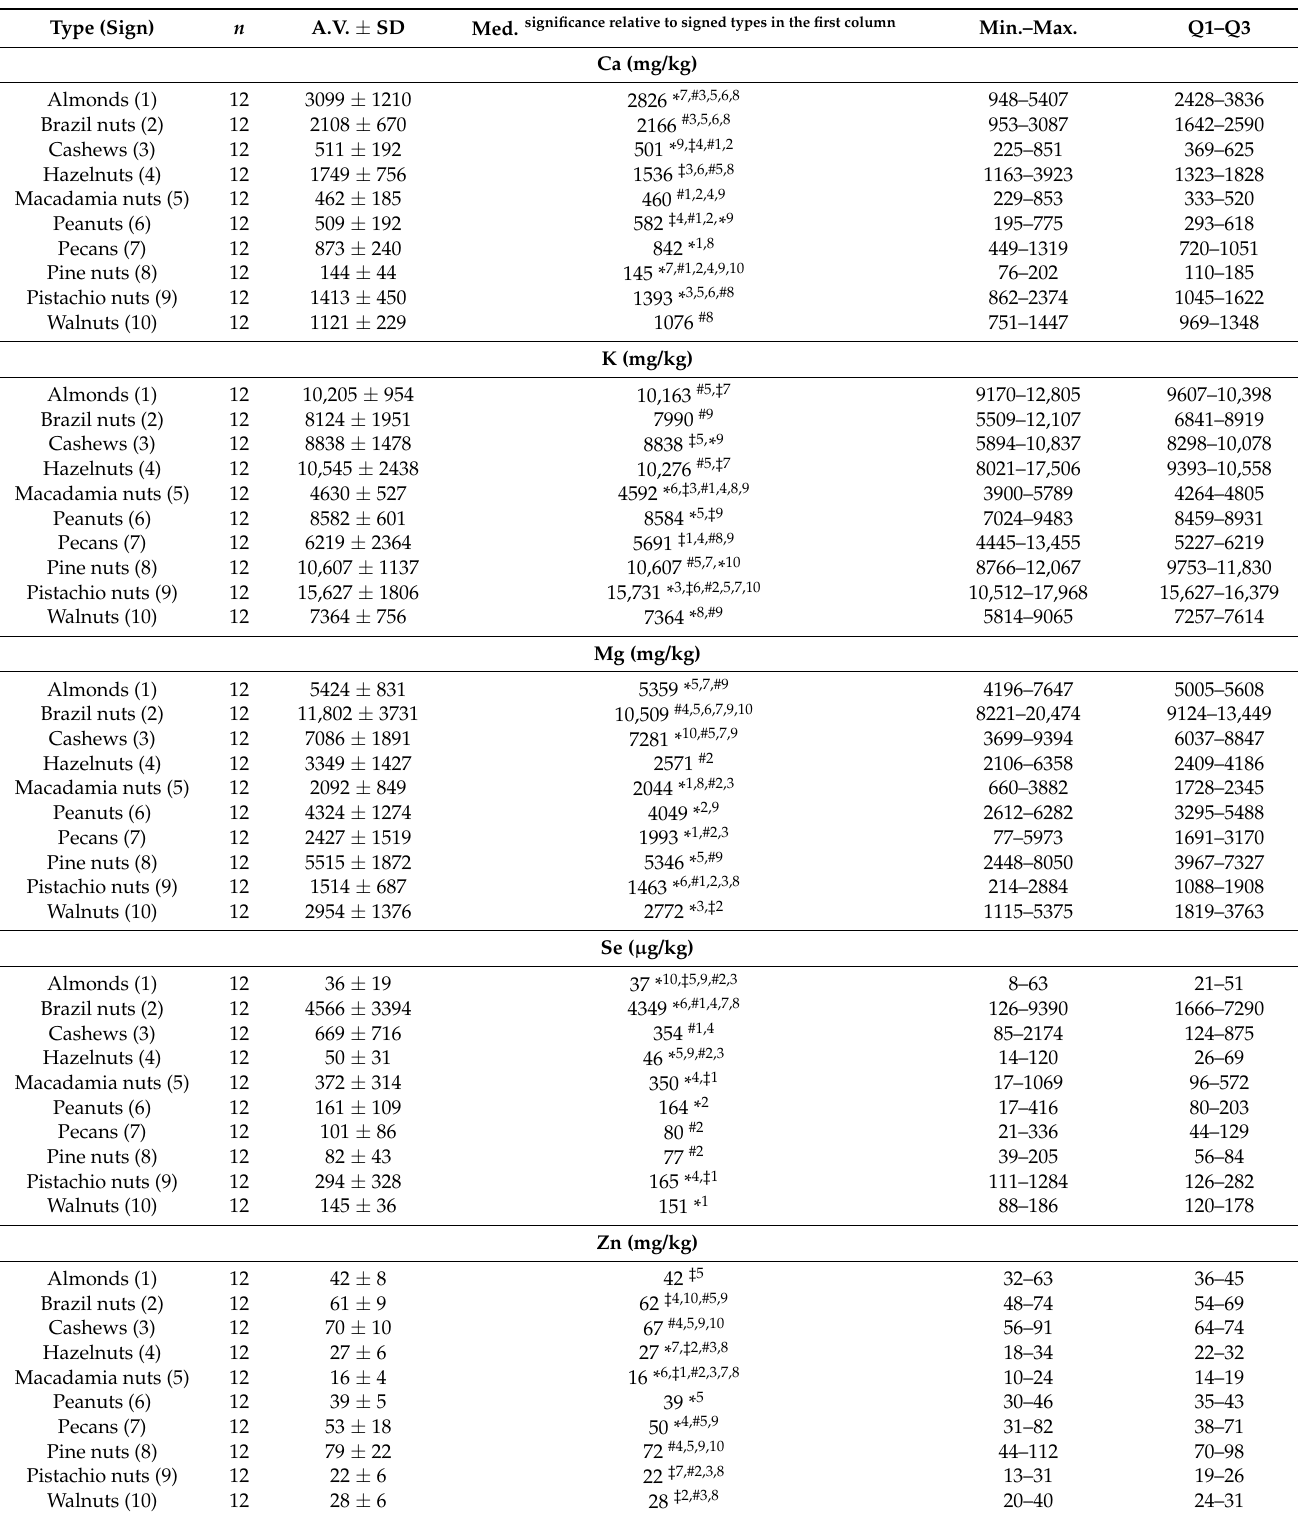
Table 1. Ca, K, Mg, Se, and Zn contents in various type of